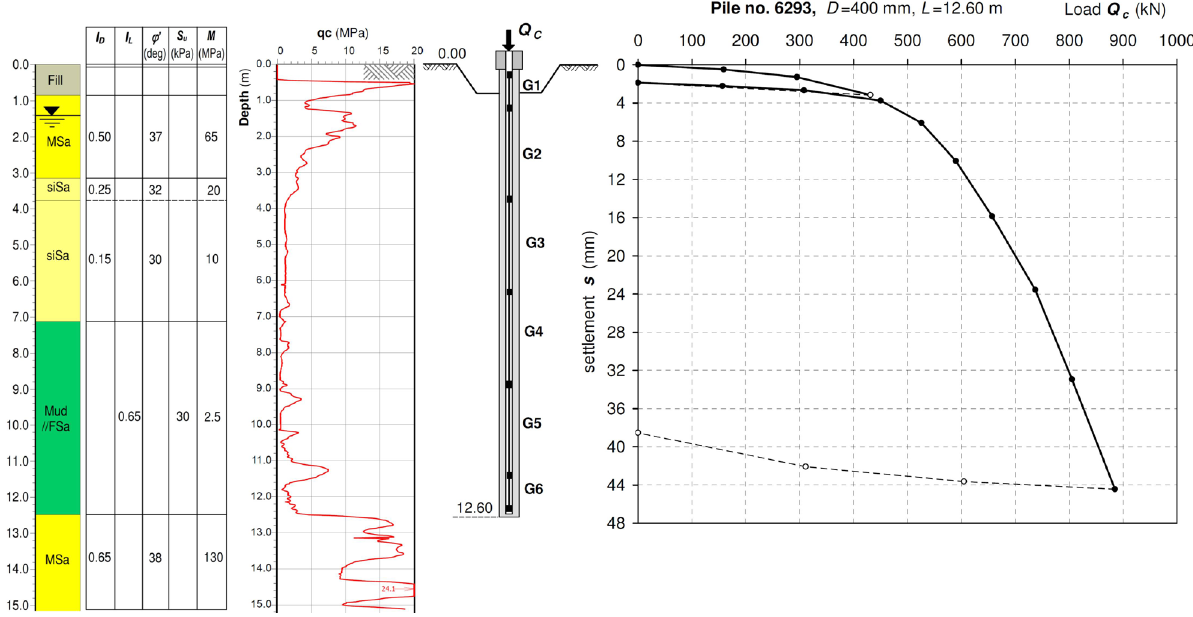
Figure 6: Pile no. 6293, CPTu sounding and the basic result of the load